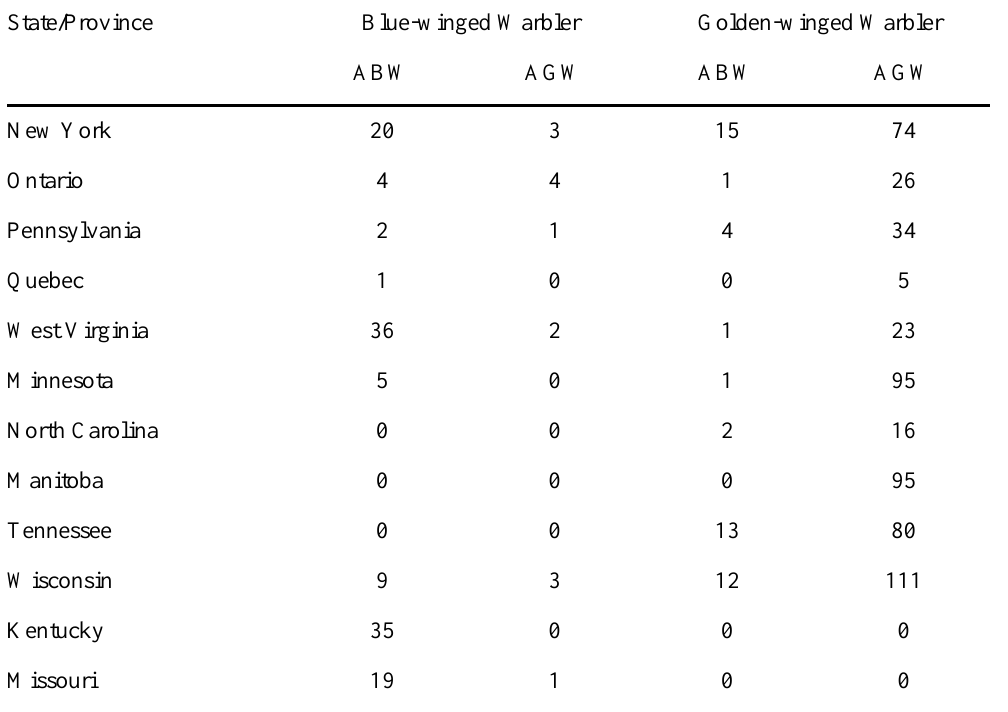
Table 2 . Phenotype by mitochondrial DNA haplotype associations listed by state/ province. Numbers indicate individuals. ABW = ancestral Blue-winged Warbler mitochondrial haplotype group, AGW = ancestral Golden-winged Warbler mitochondrial haplotype group. State/Province Blue-winged Warbler Golden-winged Warbler ABW AGW ABW